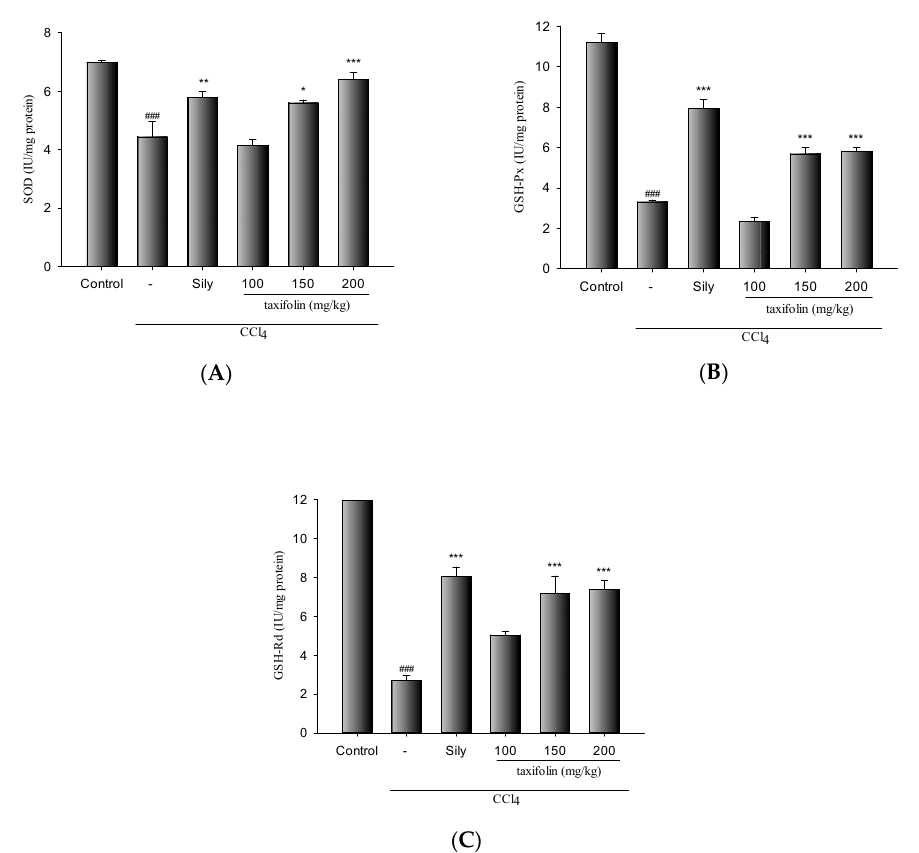
Figure 4. Taxifolin and Sily effects on the activities of hepatic superoxide dismutase (SOD) ( A ), glutathione peroxidase (GPx) ( B ), and glutathione reductase (GRd) ( C ) in CCl 4 -treated mice; data are presented as means ± SEM ( n = 10). ### p < 0.001, compared with the control group; * p < 0.05 and ** p < 0.01, compared with the CCl 4 group. One-way ANOVA followed by Tukey–Kramer tests was used to identify the differences.